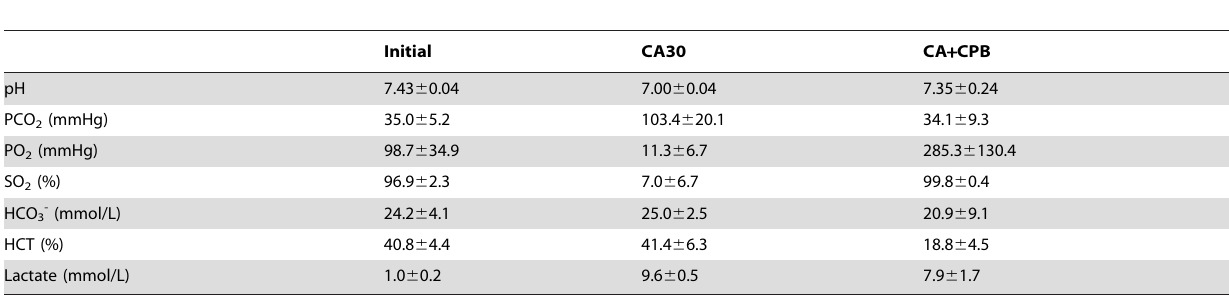
Table 1. Blood gas analysis, hematocrit, and lactate levels at baseline, 30 min post cardiac arrest, and 60 min post CPB (mean 6 standard deviation,